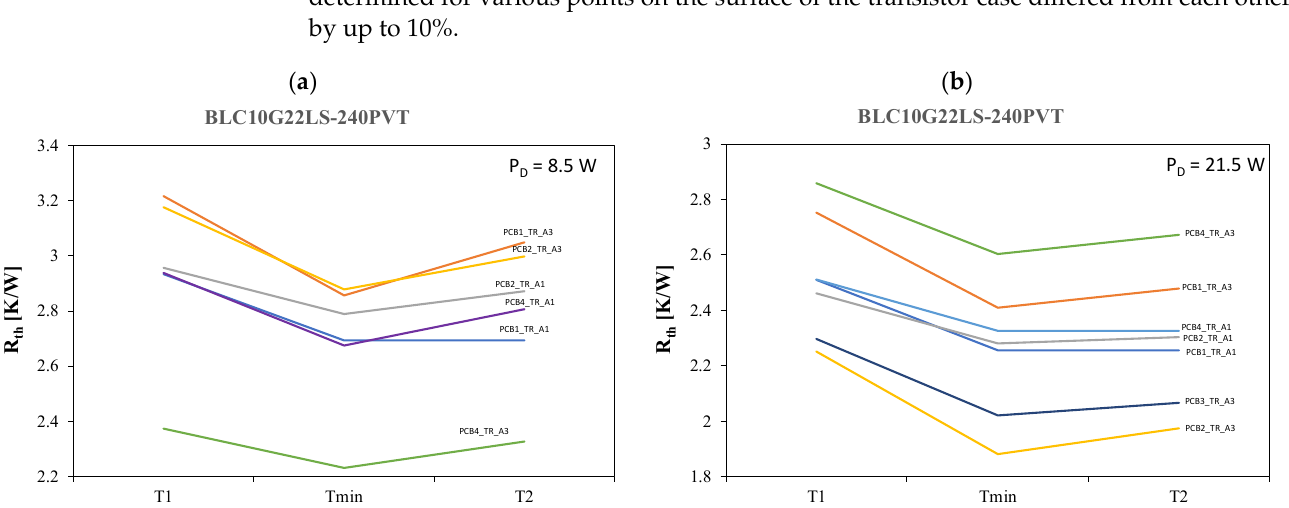
Figure 16. Dependences of R th on the case temperature for the tested transistors at P D = 8.5 W ( a ) and P D = 21.5 W ( b ).